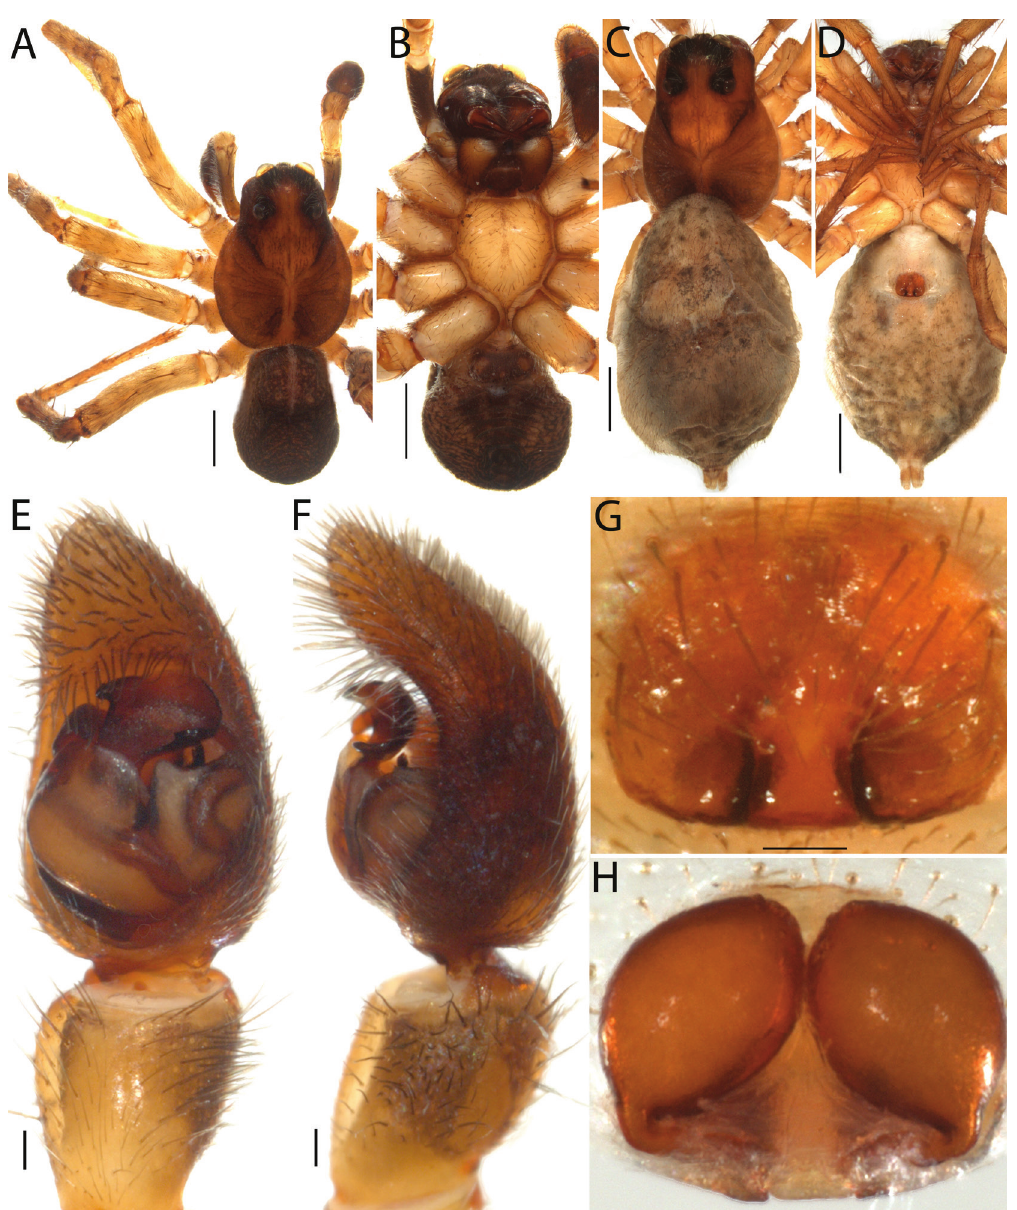
Figure 22. Artoria grahammilledgei sp. n., male holotype (AM KS127756), female paratype (AM KS9756): A , male habitus, dorsal view; B , male habitus, ventral view; C , female habitus, dorsal view; D , female habitus, ventral view; E, male pedipalp, ventral view; F , male pedipalp, retrolateral view; G , epigyne, ventral view; H , epigyne, dorsal view. Scale bars: habitus 1.0 mm; palp, epigyne 0.1